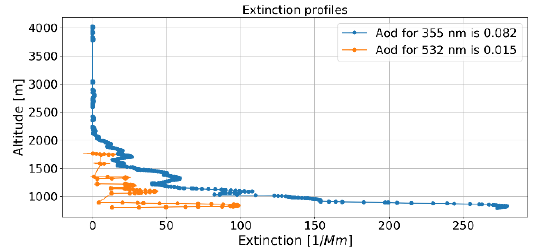
Figure 1 Extinction profiles from Lidar system